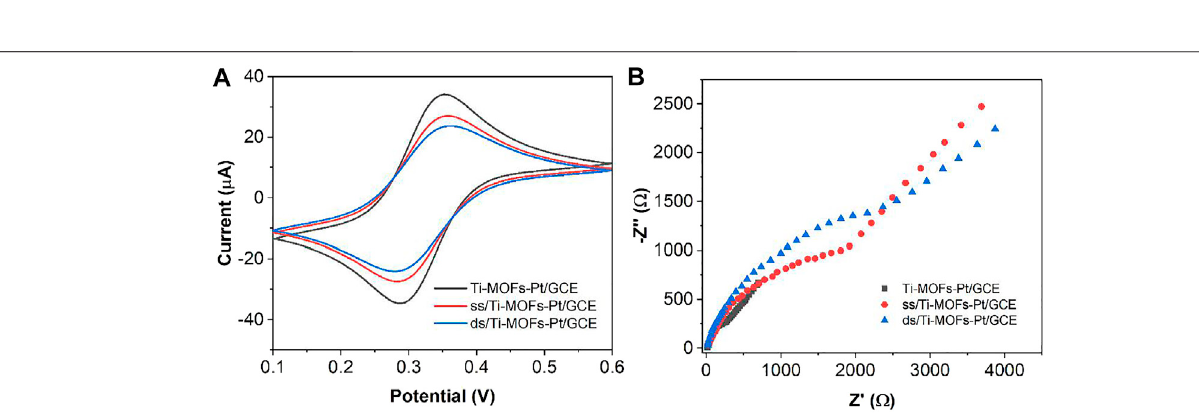
FIGURE 6 | Scheme representation of electrochemical aptamer sensor assembly and detection.